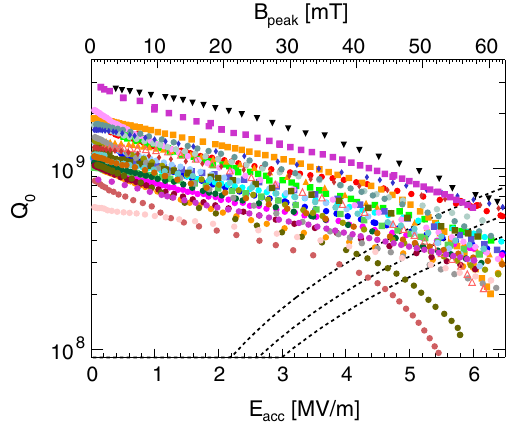
FIG. 12. Area distribution function of rf field B over the rf surface as a weight factor of surface